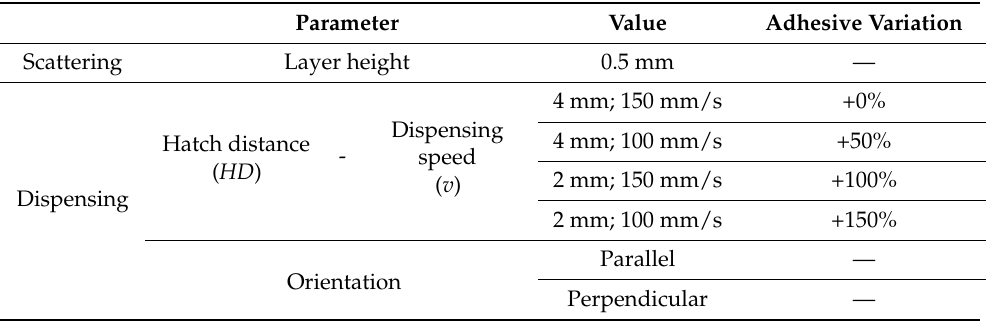
Table 2. Production parameters for the flexural and tensile specimens. Parameters not specified are identical to the ones presented in Table 1.